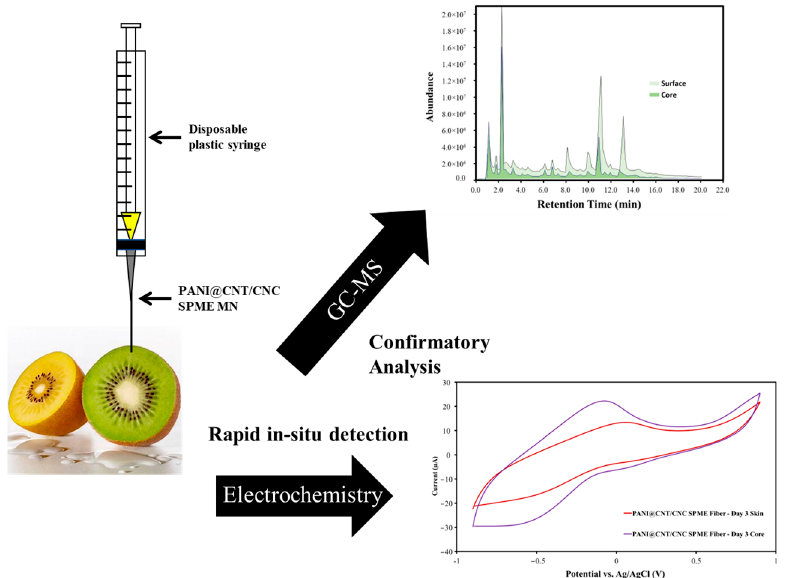
Figure 1. Schematic for the dual SPME sensor platform for electrochemical and GC-MS detection.